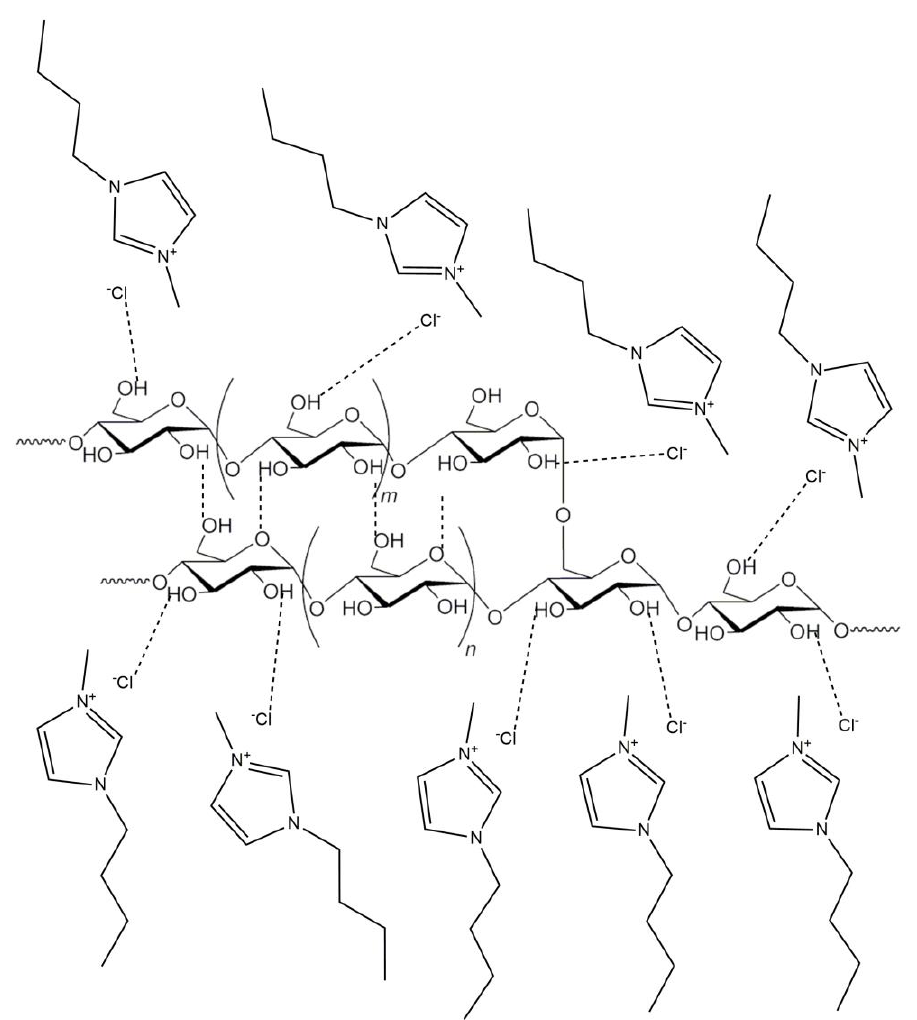
Figure 5. Mechanism of starch gelatinization in 1-butyl-3-methylimidazolium chloride.